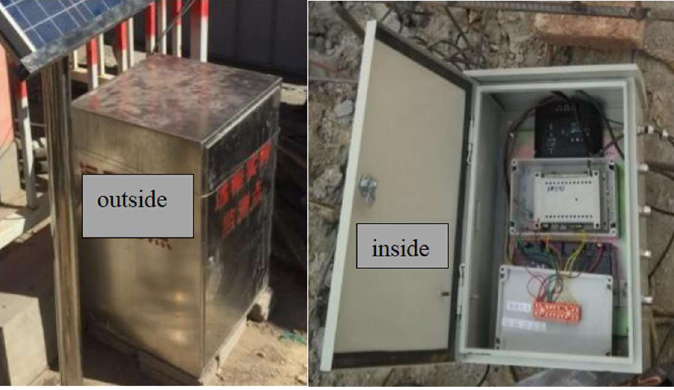
Figure 4. Data acquisition module.